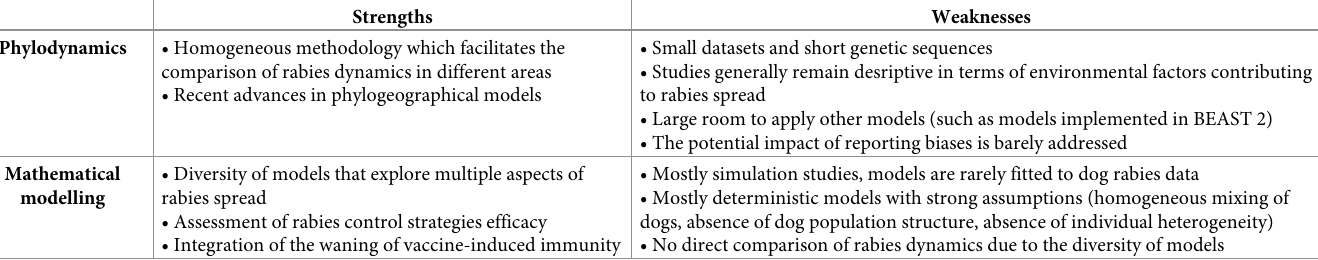
Table 3. Strengths and weaknesses of phylodynamics and mathematical modelling studies identified in this review for the study of rabies.